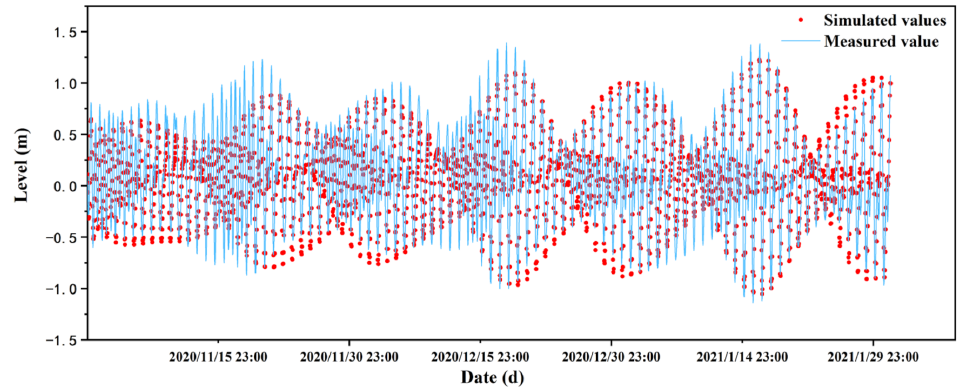
Figure 3. Comparison of simulated and measured water levels at the Daya Bay tidal